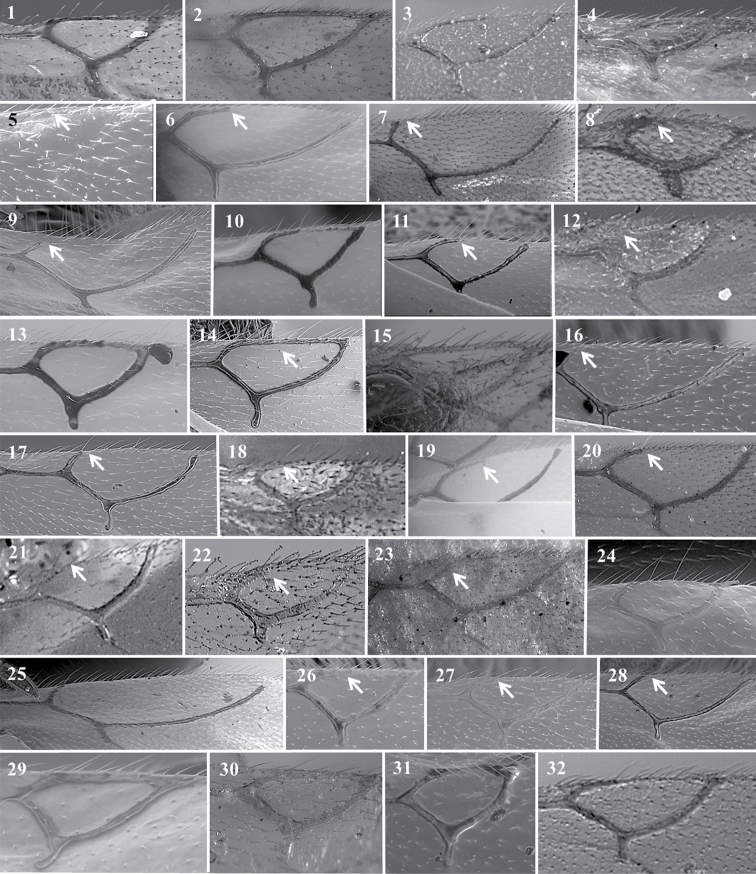
Alloxysta radial cell. A.lachni (1); A.leunisii (2); A.longipennis (3); A.longiventris (4); A.luismii (5); A.macrophadna (6); A.mara (7); A.marshalliana (8); A.medinae (9); A.mexicana (10); A.melanogaster (11); A.minuscula (12); A.mullensis (13); A.nepalica (14); A.nigricans (15); A.nigrita (16); A.nipona (17); A.nothofagi (18); A.obscurata (19); A.pallidicornis (20); A.paretasmartinezi (21); A.patens (22); A.piceomaculata (23); A.pilipennis (24); A.pilosa (25); A.pleuralis (26); A.postica (27); A.proxima (28); A.pusilla (29); A.quedenfeldti (30); A.ramulifera (31); A.rubidus (32).